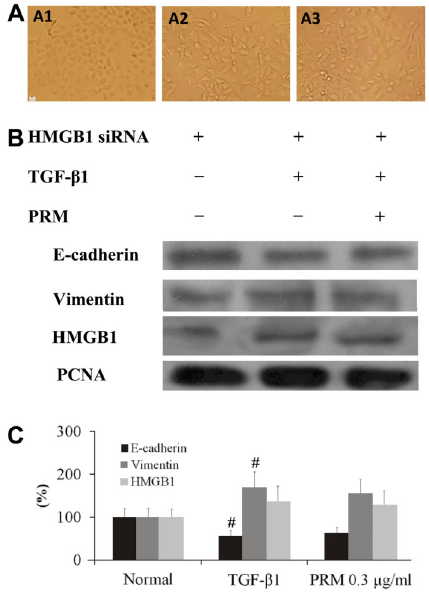
Figure 2. Effects of pulmonary rehabilitation mixture (PRM) on epithelial-mesenchymal transition (EMT) in high mobility group protein B1 (HMGB1) small interfering RNA (siRNA) A549 cells. Representative light microscopic appearance of HMGB1 siRNA A549 cells for HMGB1 siRNA A549 ( A1 ), transforming growth factor (TGF)- b 1-treated HMGB1 siRNA A549 ( A2 ), and TGF- b 1++PRM 0.3 m g/mL HMGB1 siRNA A549 ( A3 ). B - D , HMGB1 siRNA A549 cells were incubated with TGF- b 1 (5 ng/mL) for